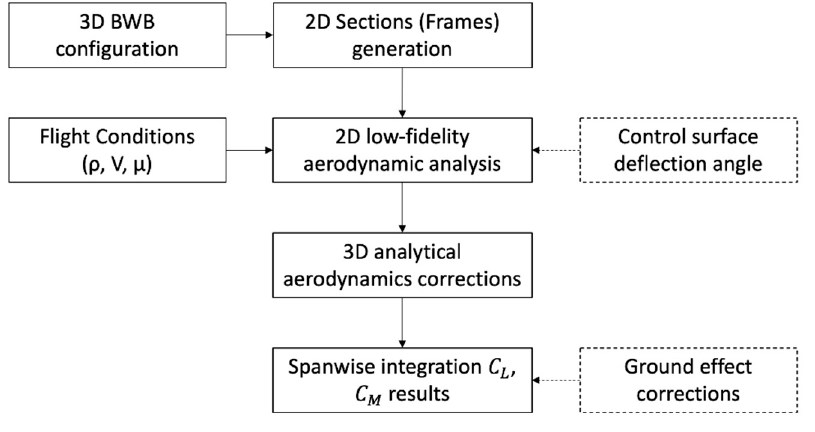
Figure 1. Quasi-3D method